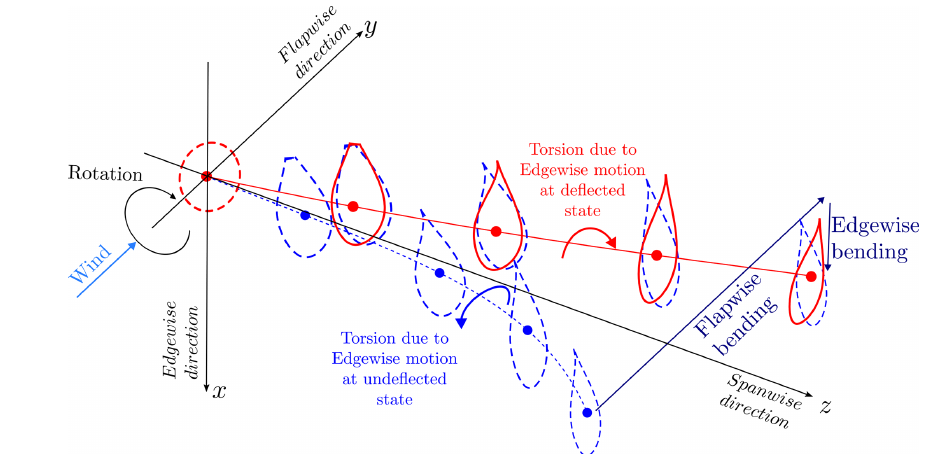
Figure 3. Illustration of wind turbine deflections in flapwise ( y ) and edgewise ( x ) directions and the resulting torsion motion due to the bending–torsion coupling at the deflected state. The lateral ( x , y ) and axial ( z ) directions are given in blade root coordinates. The effective blade length is the projected length onto the root coordinate system in the axial direction. The edgewise–torsion coupling at the initial blade position has an opposite direction in comparison to the edgewise–torsion coupling at the deflected blade